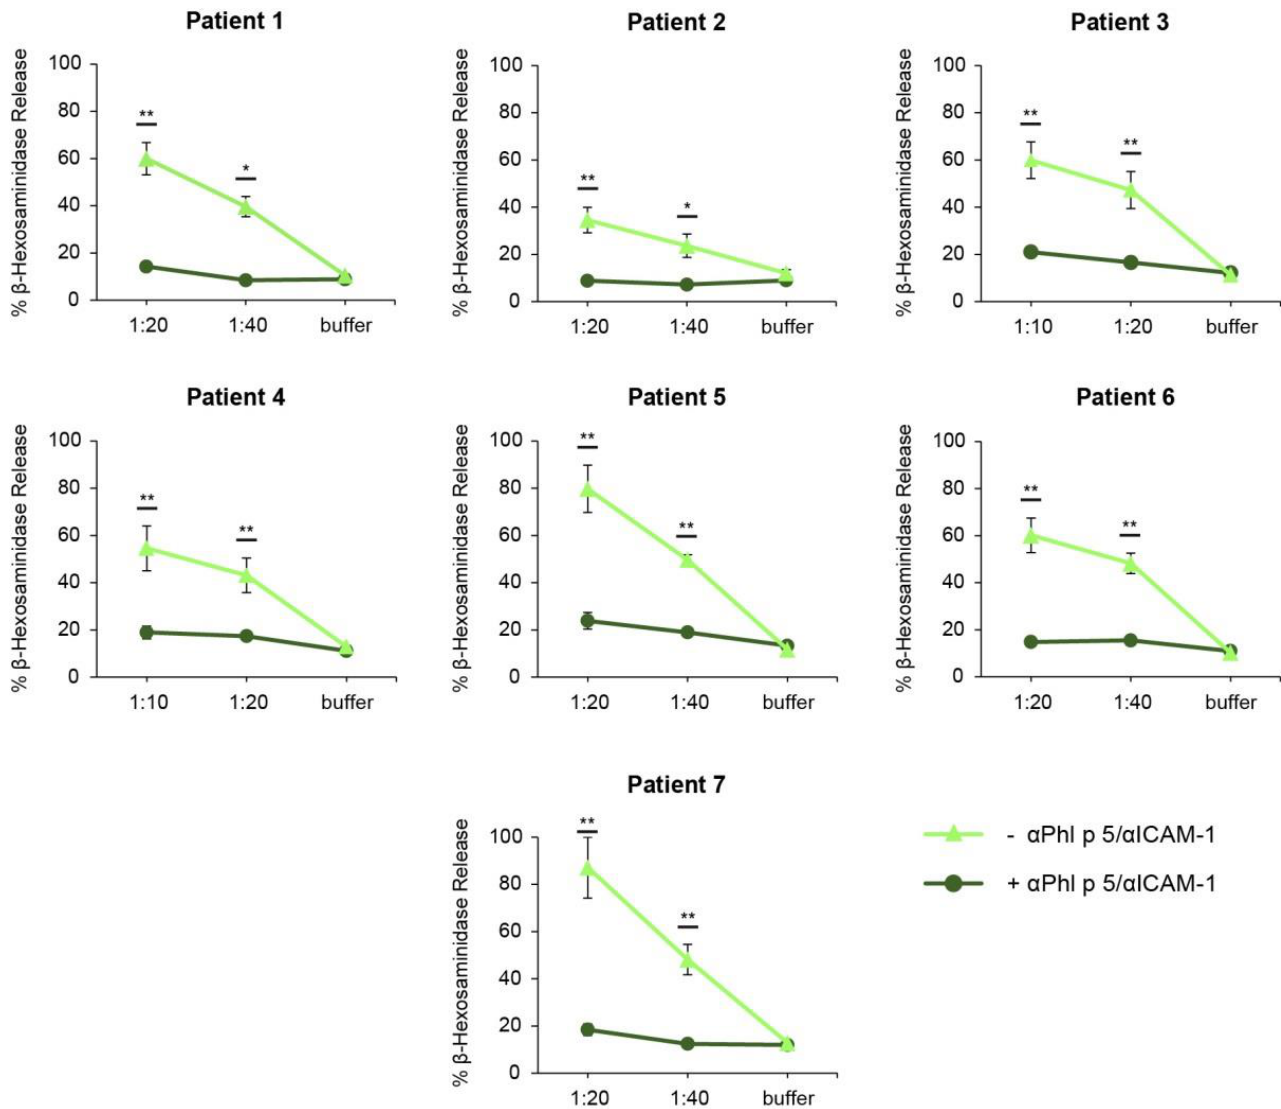
Figure 5. Inhibition of trans-epithelial migration of Phl p 5 results in decreased basophil activation. Rat basophilic leukemia (RBL) cells expressing the human Fc ε RI were pre-incubated with the sera of 7 grass pollen-allergic patients. Consequently, buffer (buffer, x -axes) or basolateral media deriving from cell monolayers treated with ( + ) or without ( − ) α Phl p 5/ α ICAM-1 conjugates were applied at two different dilutions (1:10–1:40; x -axes). The percentage of β -hexosaminidase release induced by Phl p 5 is displayed on the y -axes in relation to the total ß-hexosaminidase amount of lysed cells. Displayed graphs are representative of RBL cell assays of five independent Transwell experiments performed in duplicates. Values are shown as means of 6-fold analysis (deriving from triplicate determination of duplicates) ± SDs. The values * p < 0.05 and ** p < 0.01 show significant difference.